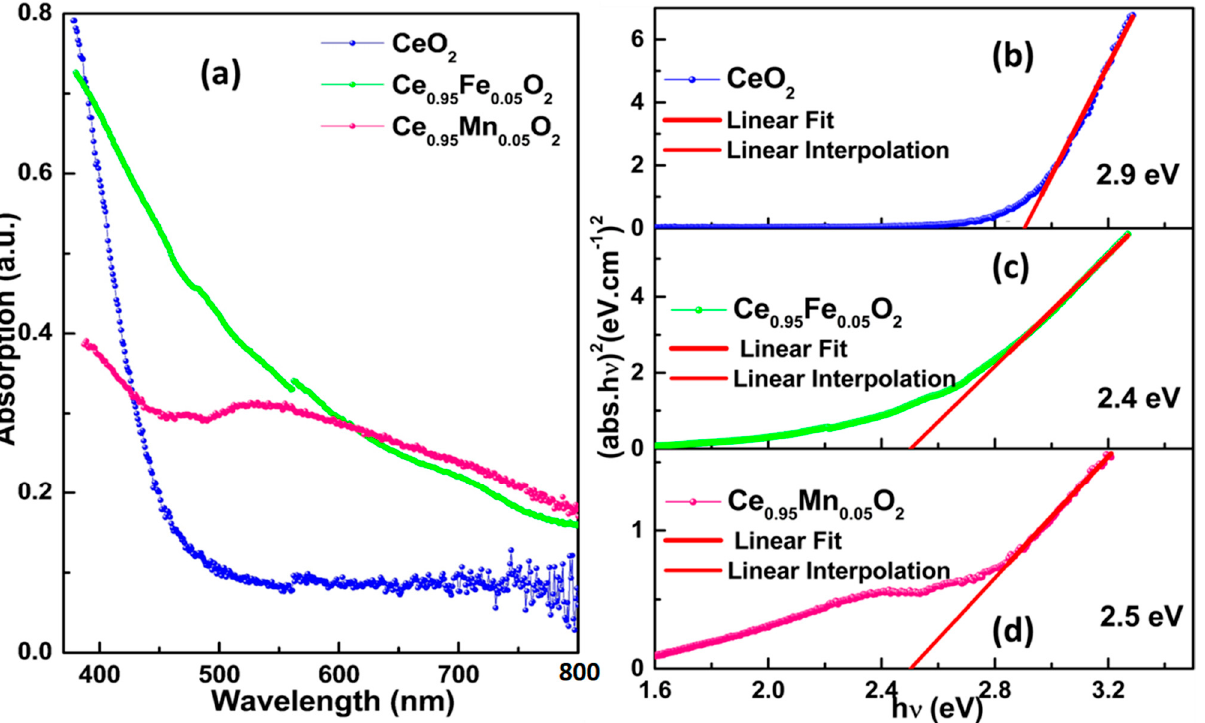
Figure 4. ( a ) UV-vis absorption curves for undoped and CeXO 2 (X: Fe, Mn) nanoparticles; ( b – d ) Tauc’s plots to determine the band gap of the respective samples.